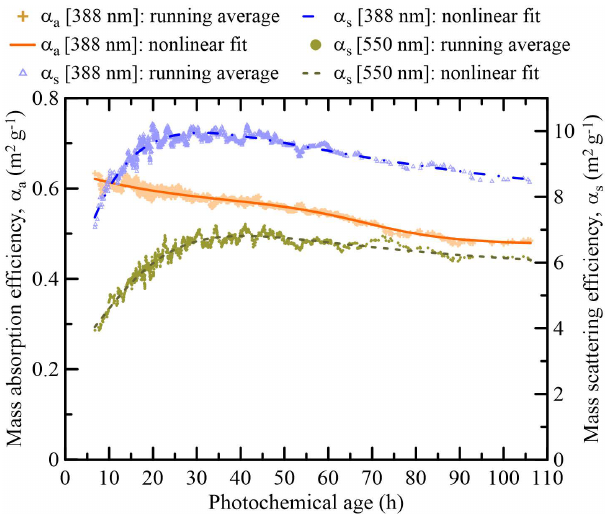
Figure 9. Evolution of the mass absorption efficiency at 388nm (left axis) and mass scattering efficiency at 388 and 550nm (right axis) according to the simulations with the CHIMERE CTM and OPTSIM module for the bb_vbs